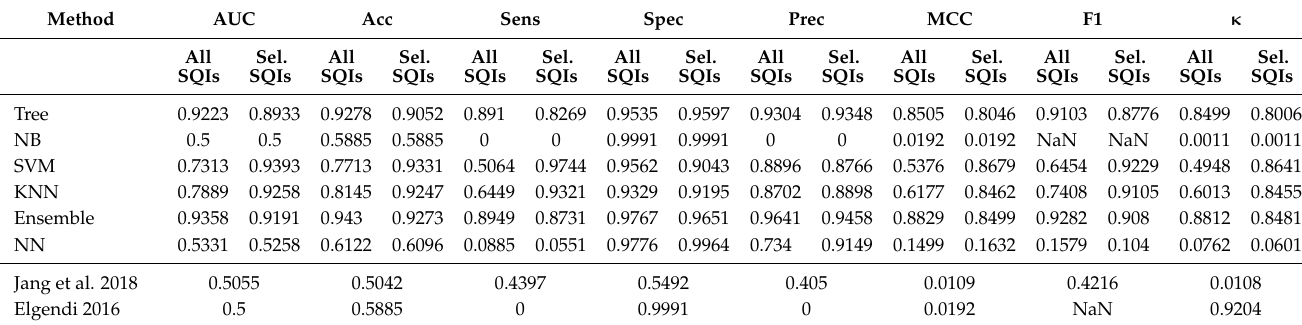
Table 6. Performances for Type 2 High-quality classifiers